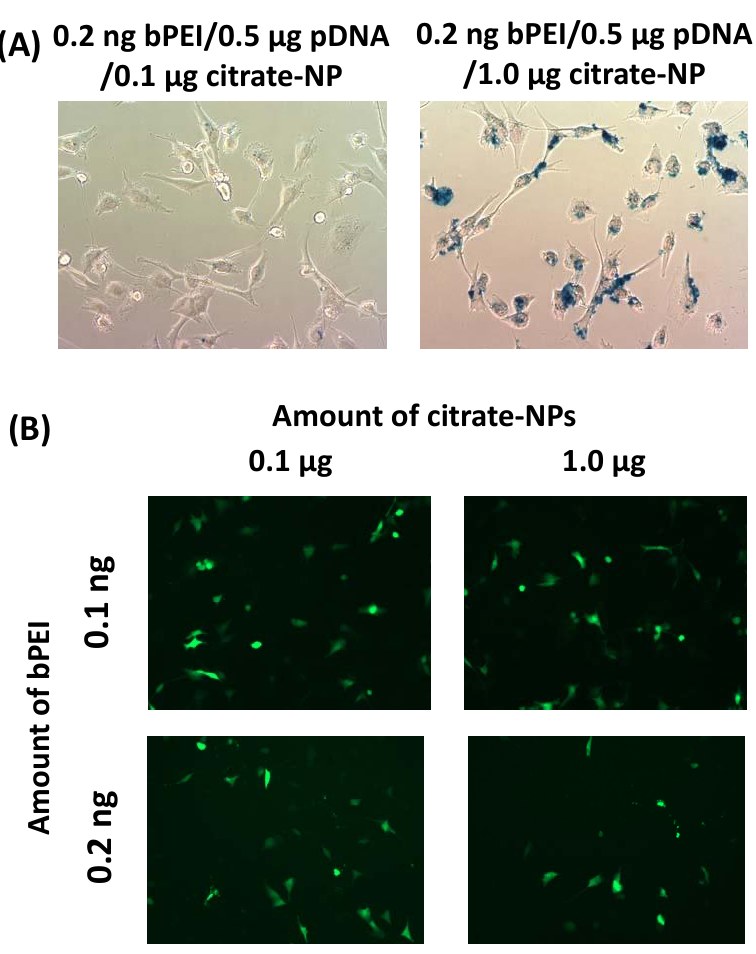
Figure 1. ( A ) Prussian staining images of two different composites 0.2 ng branched bPEI/0.5 μg pEGFP-C1 pDNA/0.1 μg citrate-NP and 0.2 ng branched bPEI/0.5 μg pEGFP-C1 pDNA/1.0 μg citrate-NP 24 h after incubation with each composite for 5 h in U87MG cells. ( B ) GFP fluorescence images of four different composites with a fixed amount of 0.5 μg pEGFP-C1 pDNA 24 h after incubation with each composite for 5 h in U87MG cells.